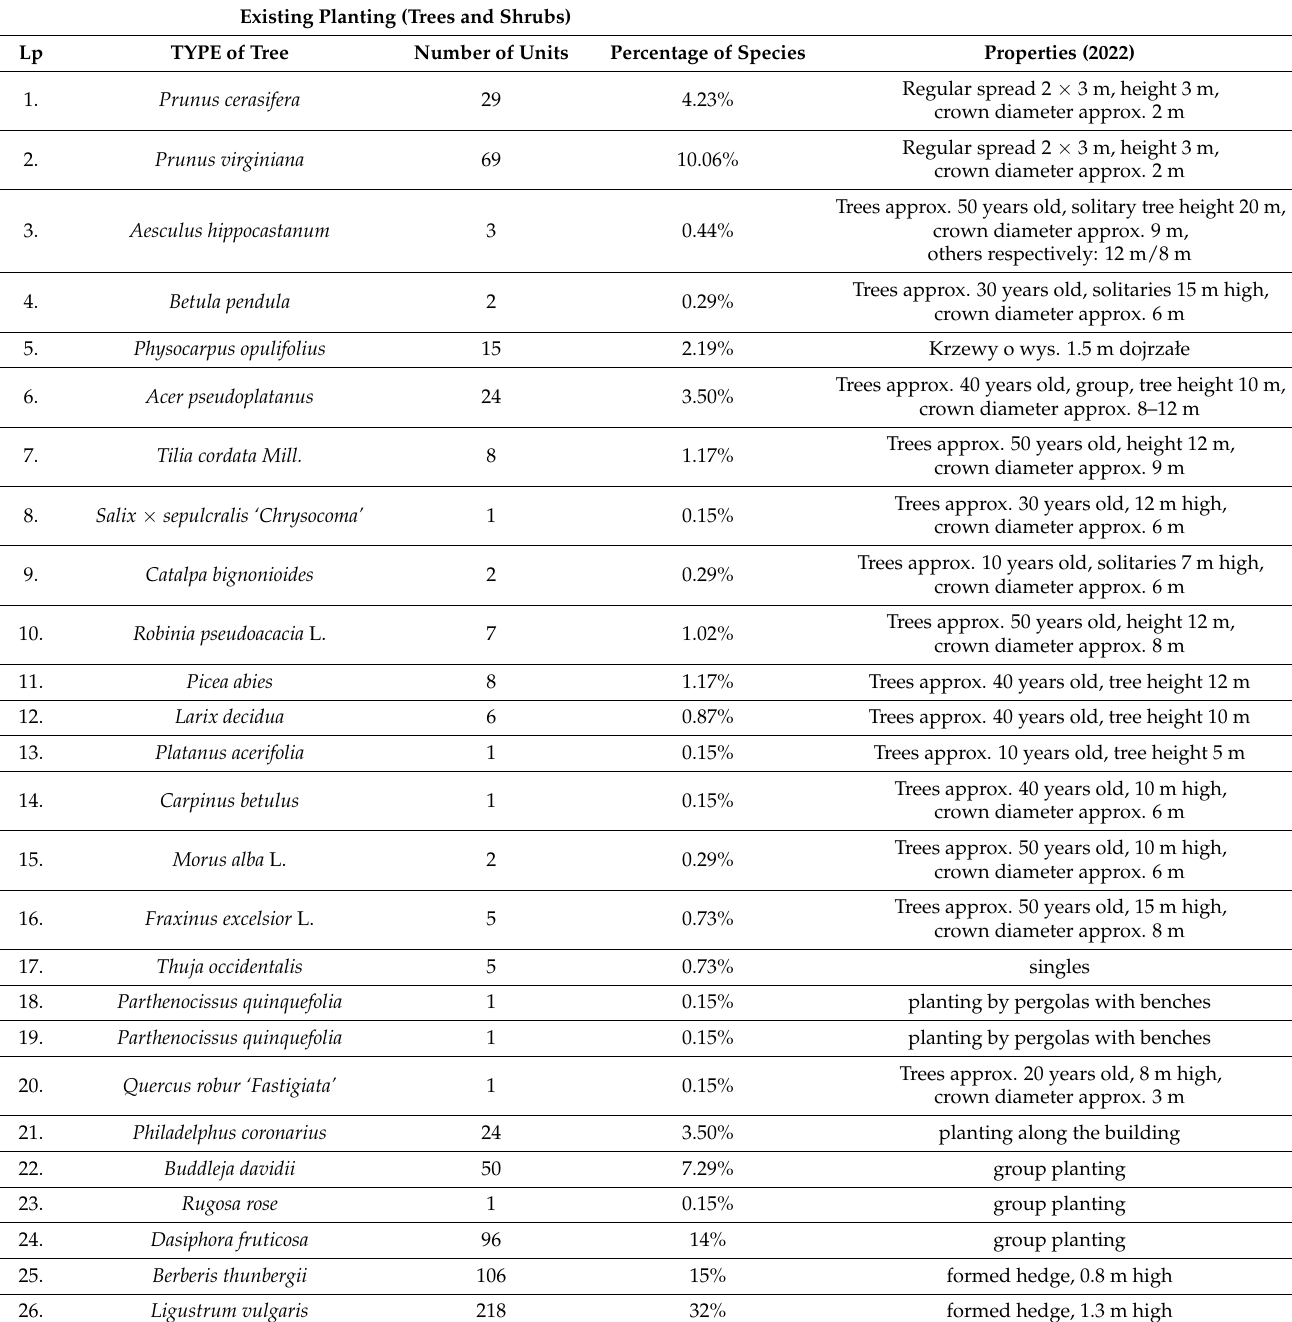
Table 3. Table listing identified tree and shrub species and their percentage share in relation to each